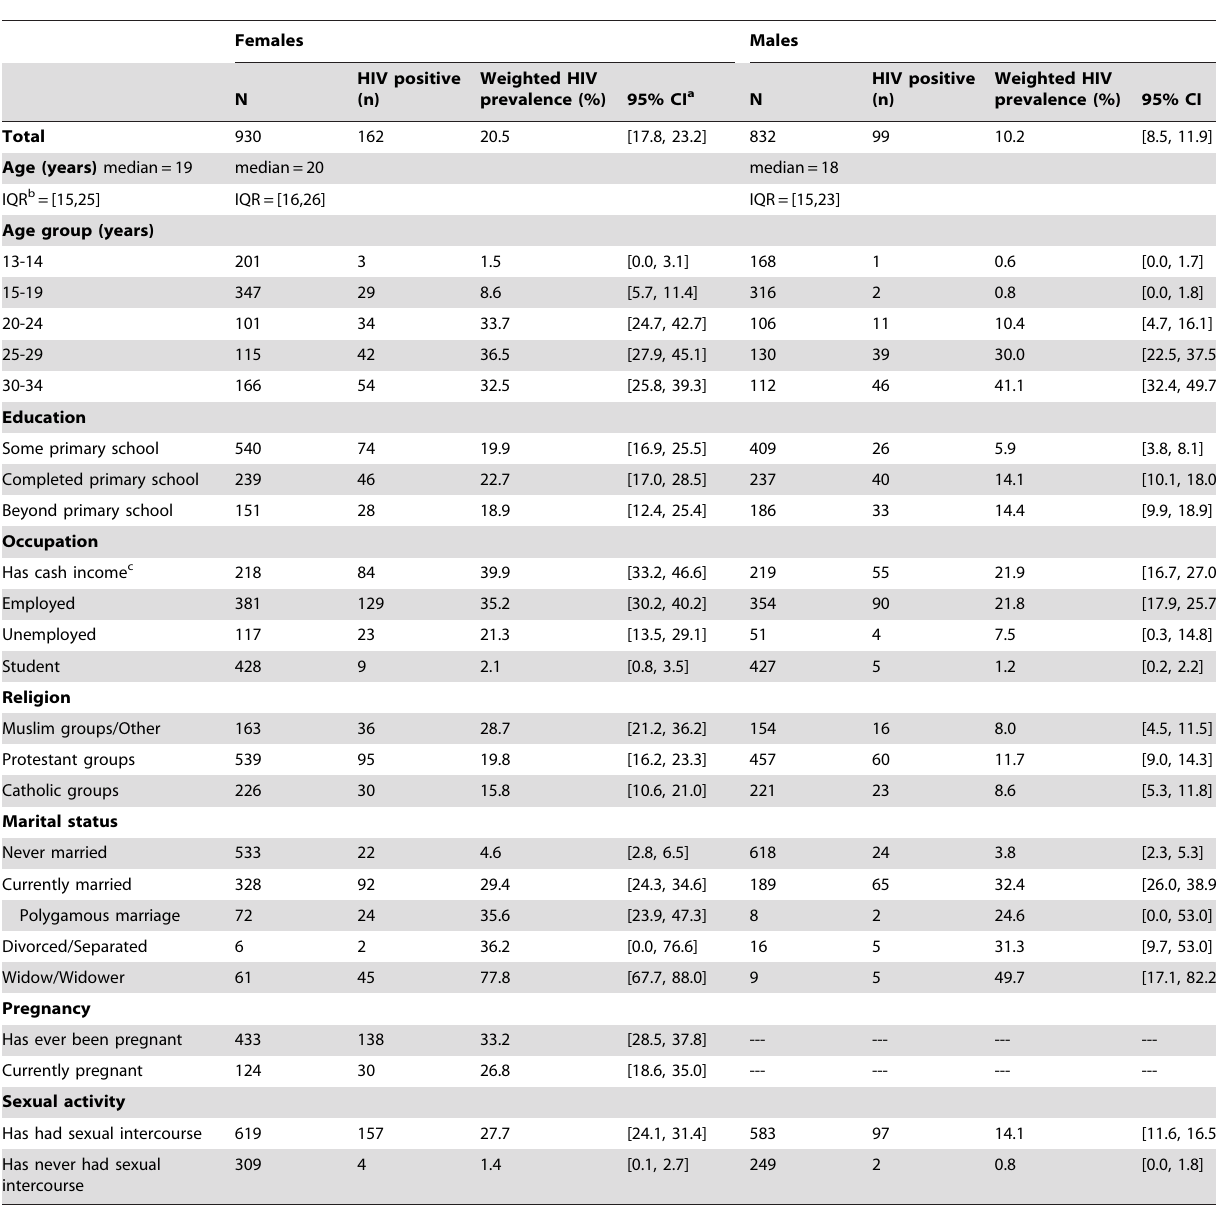
Table 1. Demographic characteristics by weighted HIV prevalence and gender,